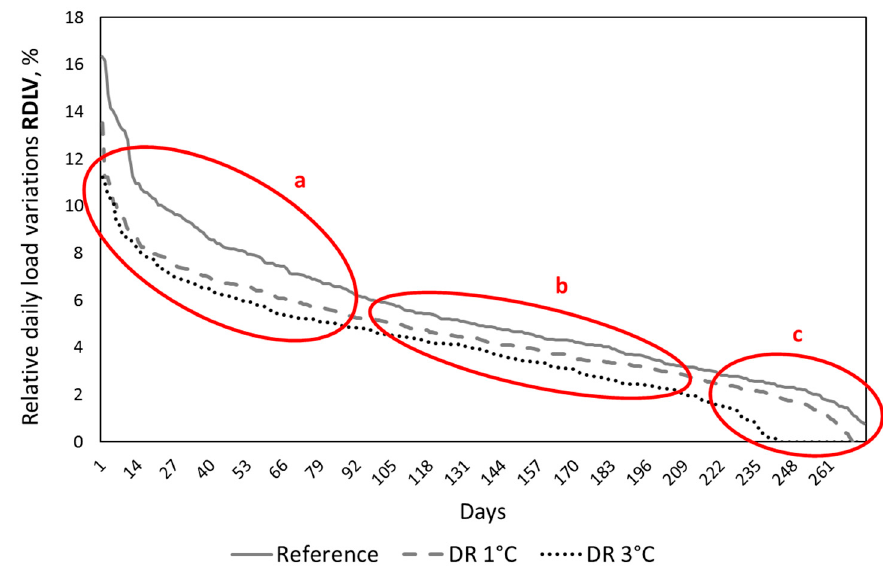
Figure 4. The Relative Daily Load Variations (RDLVs), sorted in descending order, for the investigated DH system of the City of Gothenburg, as obtained from the modeling for the Reference, DR 1 ◦ C, and DR 3 ◦ C scenarios. Note that the modeled period is limited to 273 days, excluding the summer months, during which no space heating demand, and respectively, no DR are present.